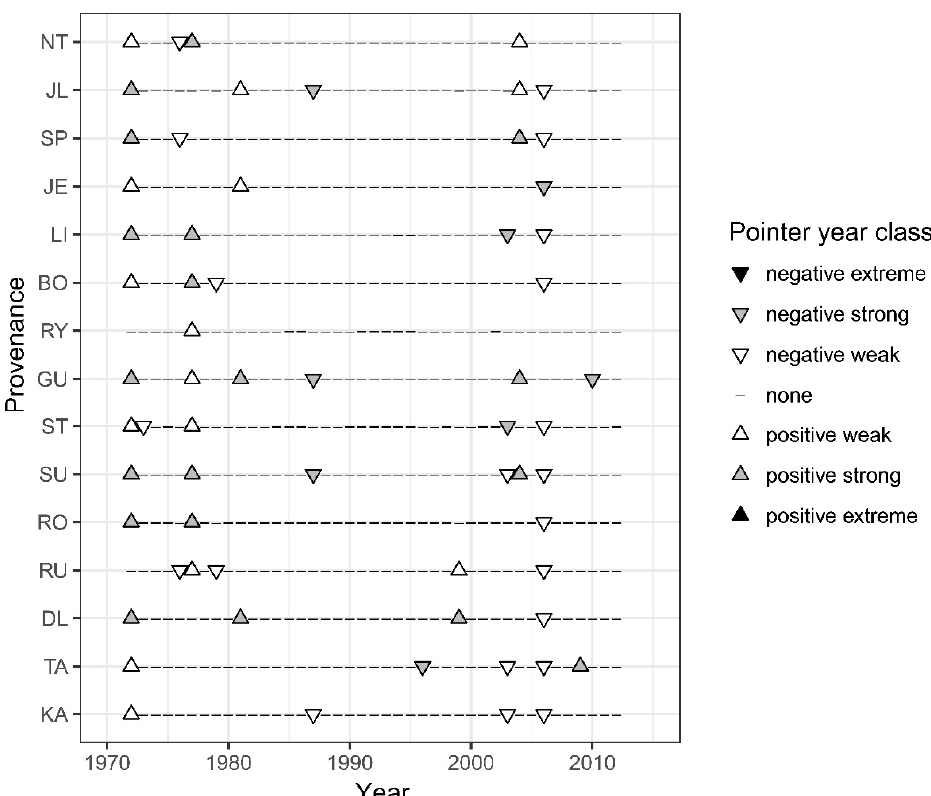
Figure 5. Common pointer years (CPY) for provenances, indicated by upper (positive) and inverted (negative) triangles. BO, DL, GU, JE, JL, KA, LI, NT, RO, RU, RY, SP, ST, SU and TA: Scots pine provenances.